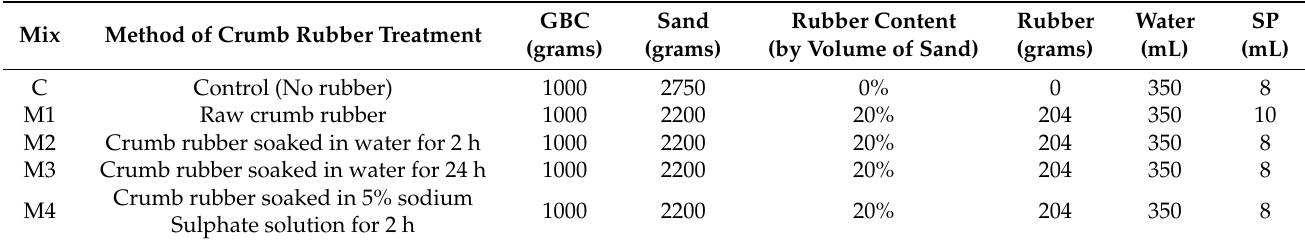
Table 3. Mortar mix